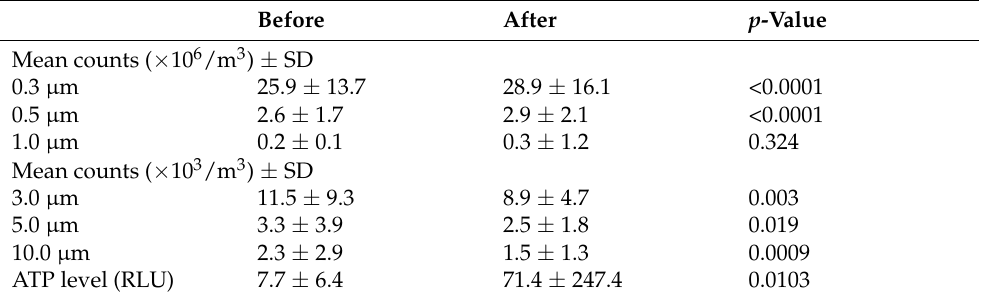
Table 2. Comparison of changes in aerosol counts and ATP levels before and after esophagogastro- duodenoscopy.